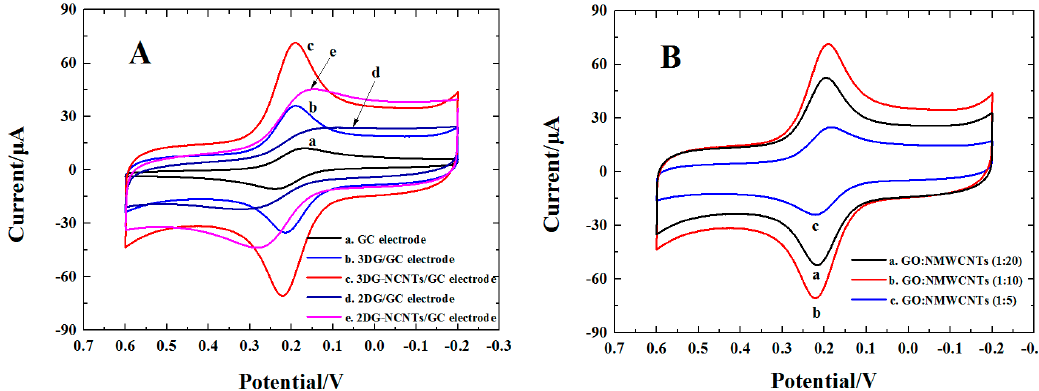
Figure 5. ( A ) Cyclic voltammograms (CVs) of bare GC electrode (curve a), 3DG (curve b), 3DG-NCNTs (curve c), 2DG (curve d), 2DG-NCNTs (curve e) modified GC electrode in 1.0 × 10 − 3 mol · L −